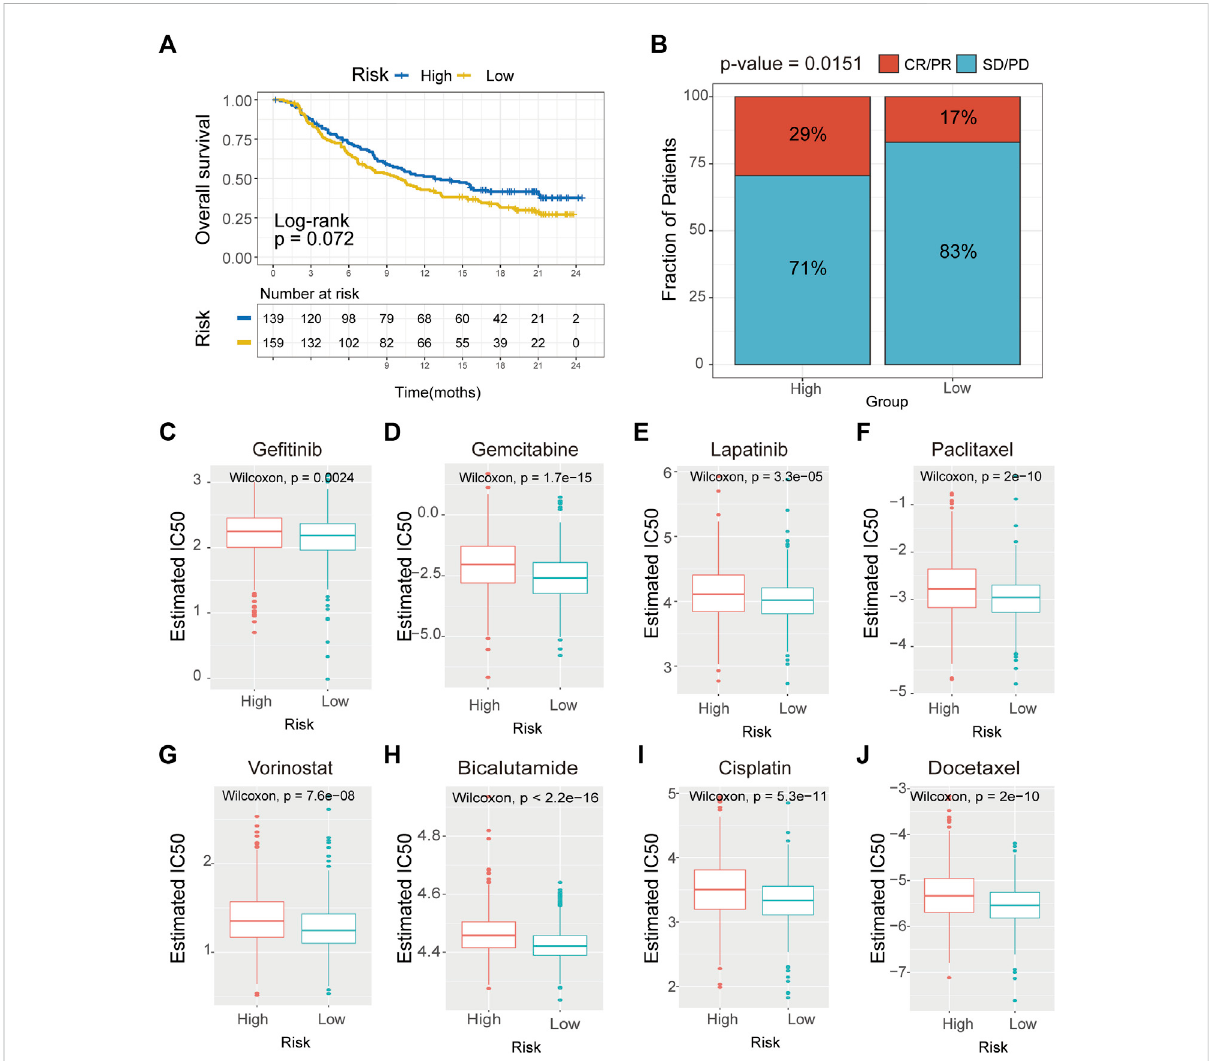
FIGURE 9 Drug sensitivity analysis of CAVs according to the prediction module. (A) Survival analysis of the drug responsiveness between the high- and low-risk subgroups according to the anti-PD-L1 cohort (IMvigor210 cohort). (B) Proportion of immune response to anti-PD-L1 treatment in high- and low-immune-risk score subgroups. (C – J) IC50 values for anticancer agents were compared between the high- and low-risk